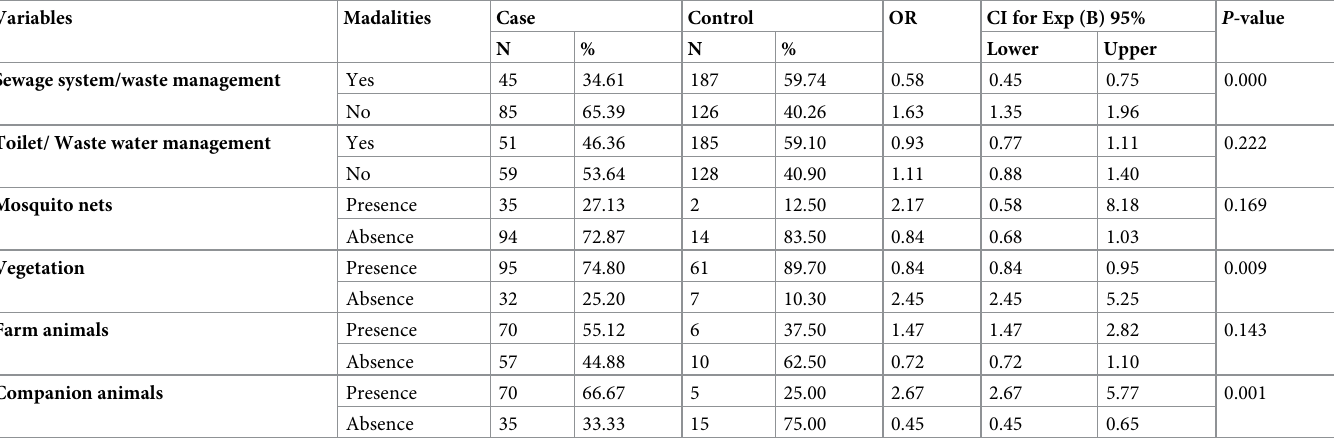
Table 3. Environmental determinants of ACL in Marrakech-Safi region, Morocco, between 2018 and 2020.